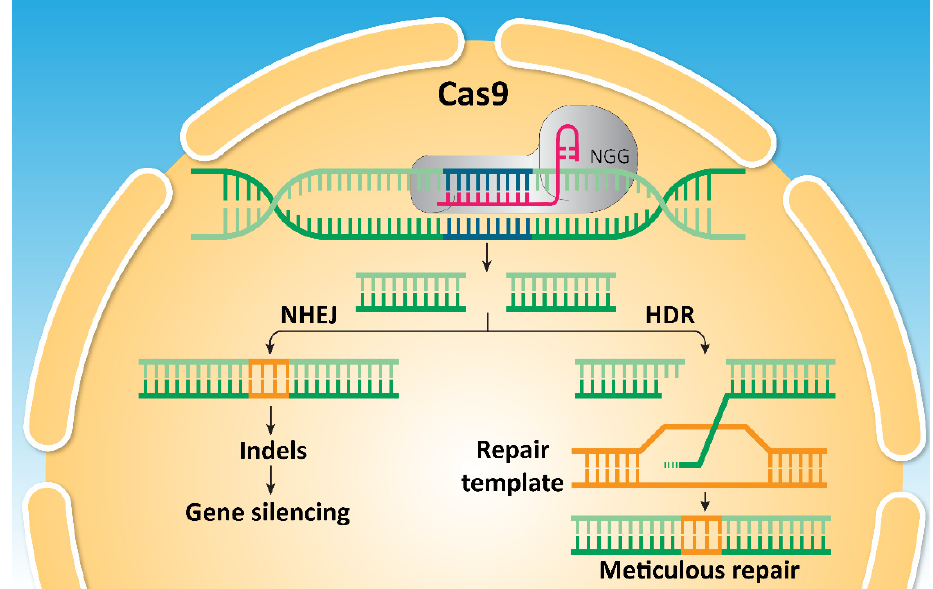
Figure 1. CRISPR-Cas9 mediated gene editing. A single Cas9 effector recognizes the target region and blunt-ended double-stranded breaks (DSBs) would be induced at target site through Cas9 endonuclease domains. The DSBs introduced by Cas9 endonuclease would promptly be repaired by the error-prone NHEJ pathway or by most specific HDR. The NHEJ pathway might result in random Indels and disrupt the sequence frame at the target site. Alternatively, when a repair template is supplied, the HDR pathway increases the accuracy and efficiency of the targeted gene editing.